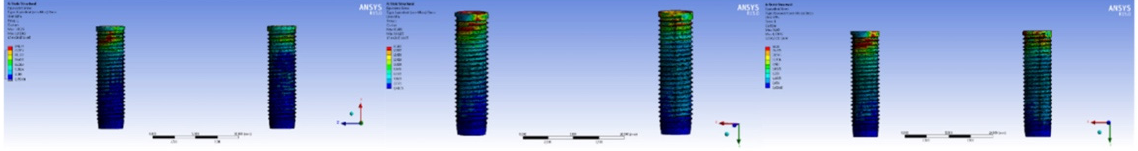
Figure 3. Model 1, Model 2 and Model 3 implants, and the distribution of Von Mises stress after vertical loading, respectively.